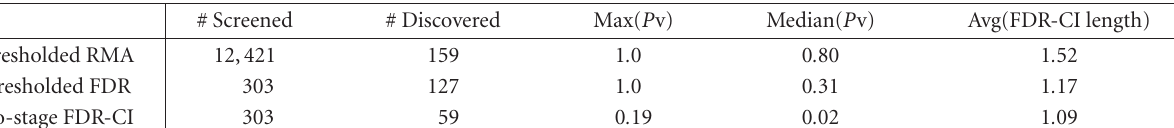
Table 3: Performance comparison of three algorithms for selecting genes with magnitude (log base 2) foldchange > 1 . 0. Thresholded RMA and Thresholded FDR are significantly worse in terms of statistical significance ( P value) than the proposed Two-stage FDR-CI algorithm (columns 4 and 5). Furthermore, the average length of the CIs on foldchanges of the discovered genes are shorter for the Two-Stage FDR-CI algorithm than for the other algorithms (column 6).